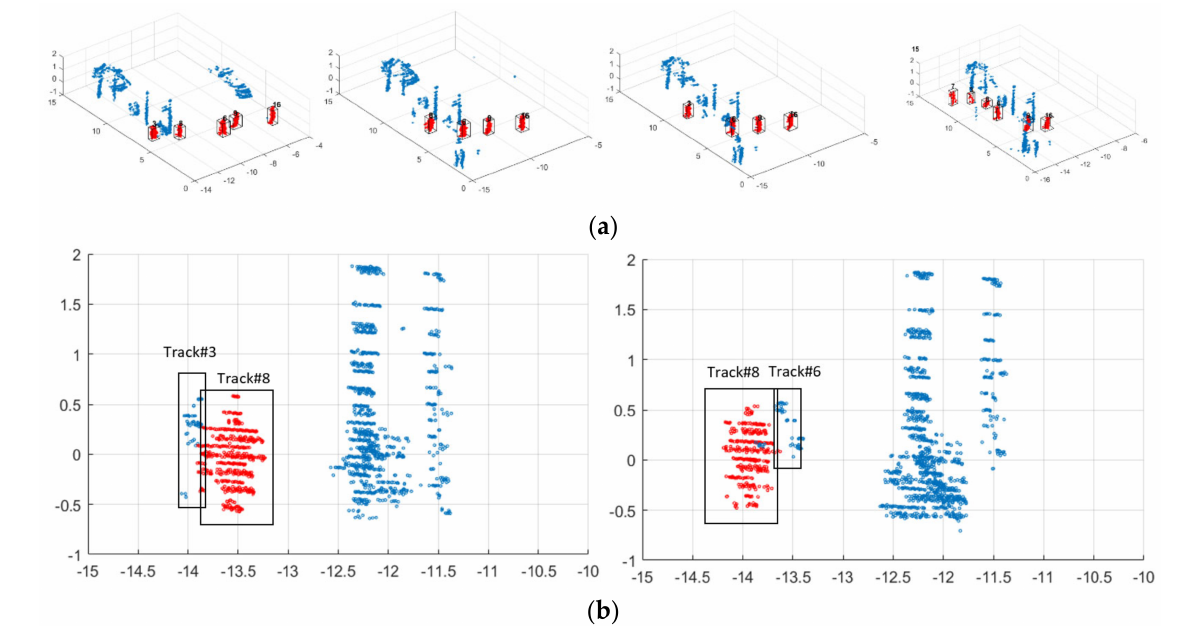
Figure 11. Examples of recovering missing detections (unit: m). ( a ) Track #3, Track #6, Track #8, Track #9 and Track #16 in frames 64, 72, 74, and 82 in Data Set I; ( b ) detailed views of frames 72 and 74.